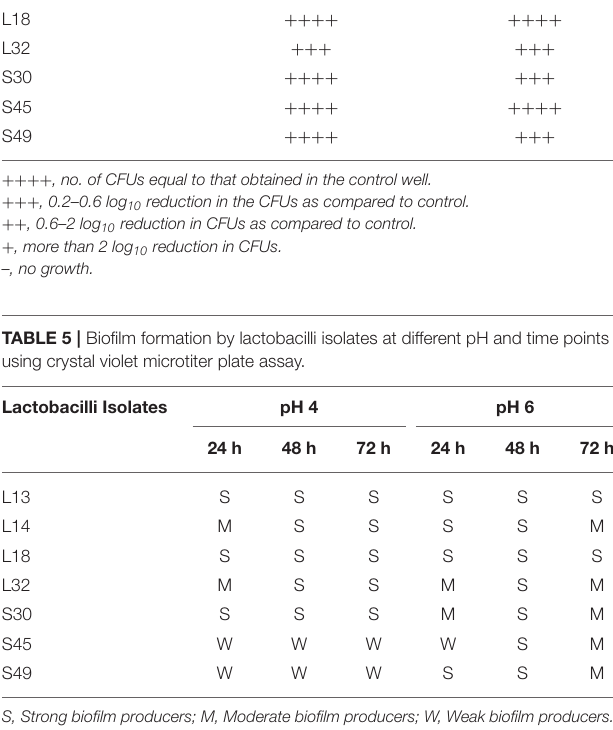
FIGURE 7 | Microscopic (1000X) image of Giemsa-stained HCT-15 cells showing adhered V. Cholera (1 and 2) and V. parahaemolyticus (3 and 4) in the absence (A) and presence (B) of CS of lactobacilli isolate L18.